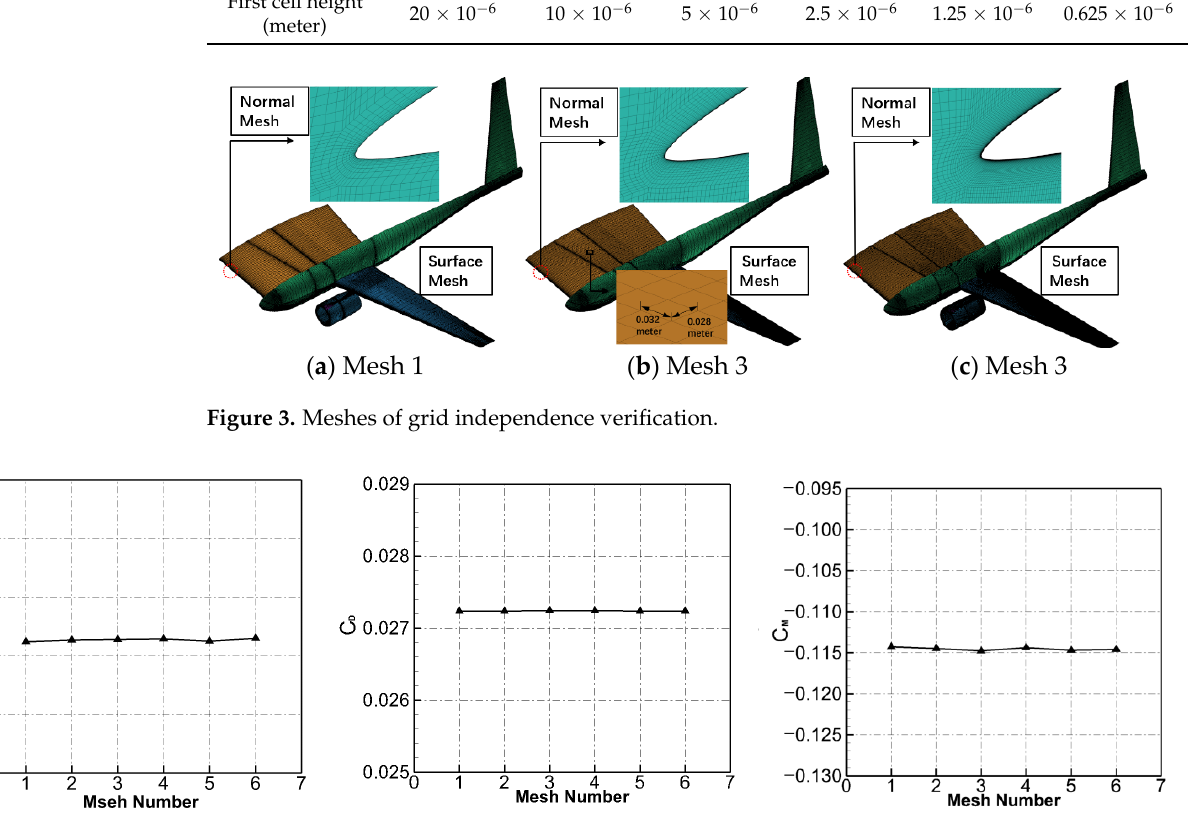
Figure 4. Aerodynamic coefficients of grid independence verification.